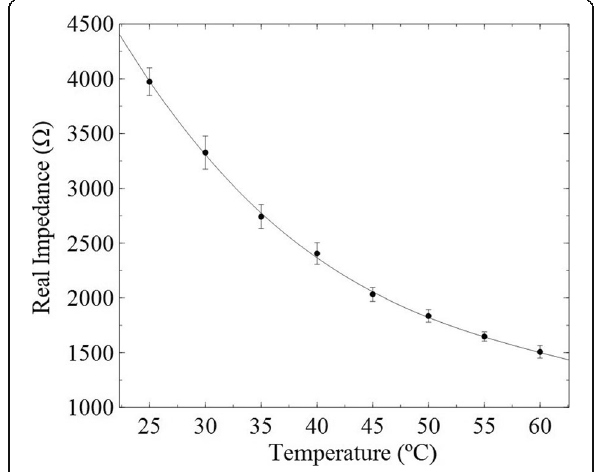
Fig. 3 Real impedance ( Ω ) vs. temperature (°C) for pure water